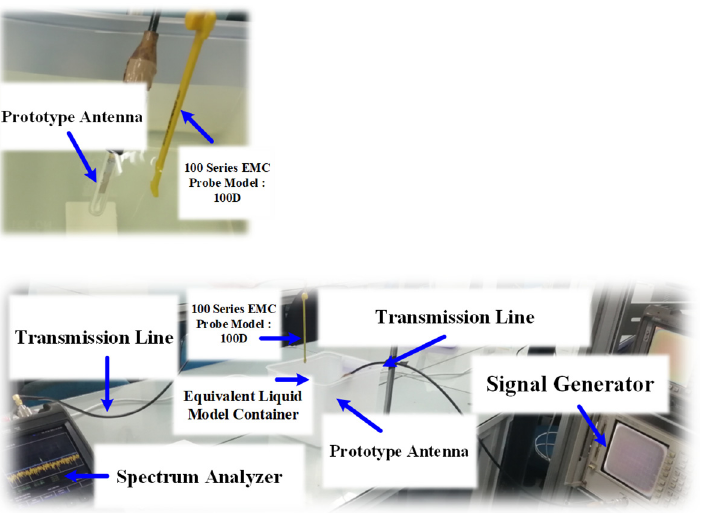
Figure 17. SAR measurement setup in equivalent liquid mixtures with the antenna prototype encapsulated in a glass